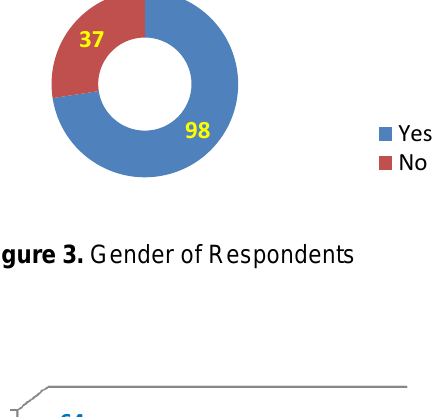
Figure 5. Purchased or Planning to Purchase